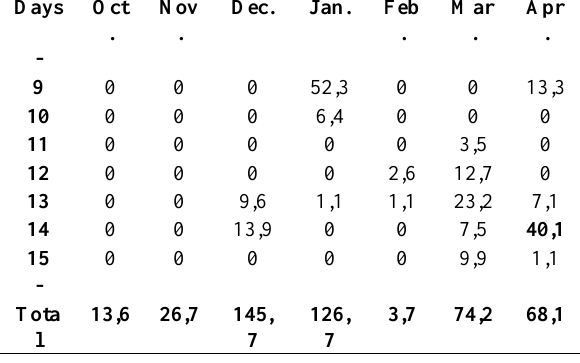
Table 1.Daily rainfall records within October 2016-April 2017 Figure 3.Calculation of cut volume of ephemeral gully by Pix4D.